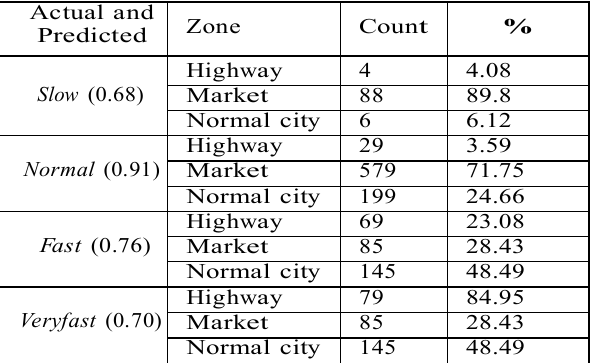
Table 12. Zonewise Prediction and Percentage for GB